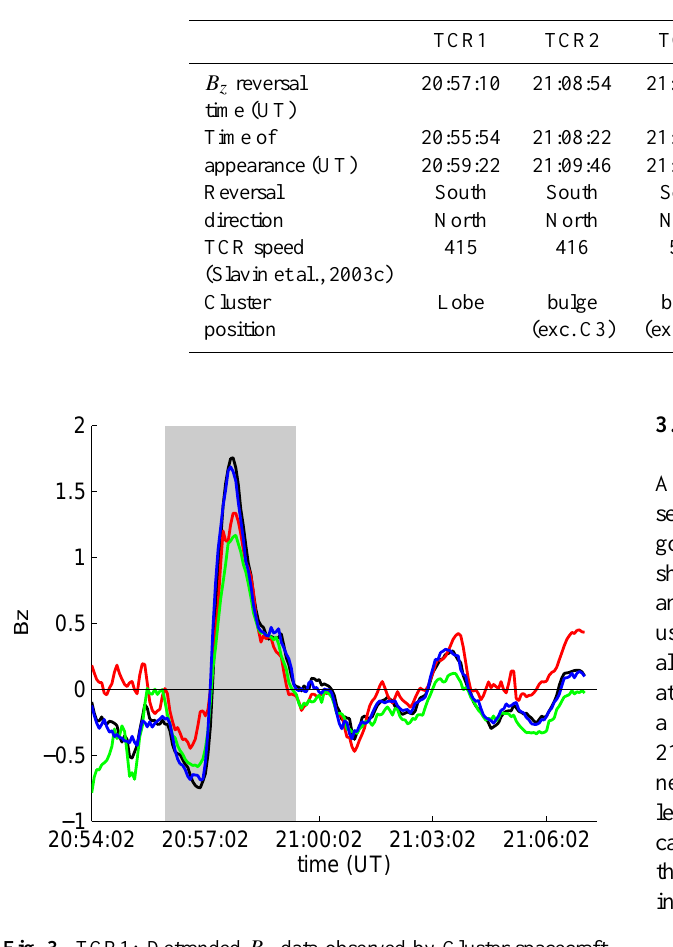
Fig. 3. TCR1: Detrended B z data observed by Cluster spacecraft during 20:54:02 and 21:07:02UT. The typical bipolar signature is visible for all